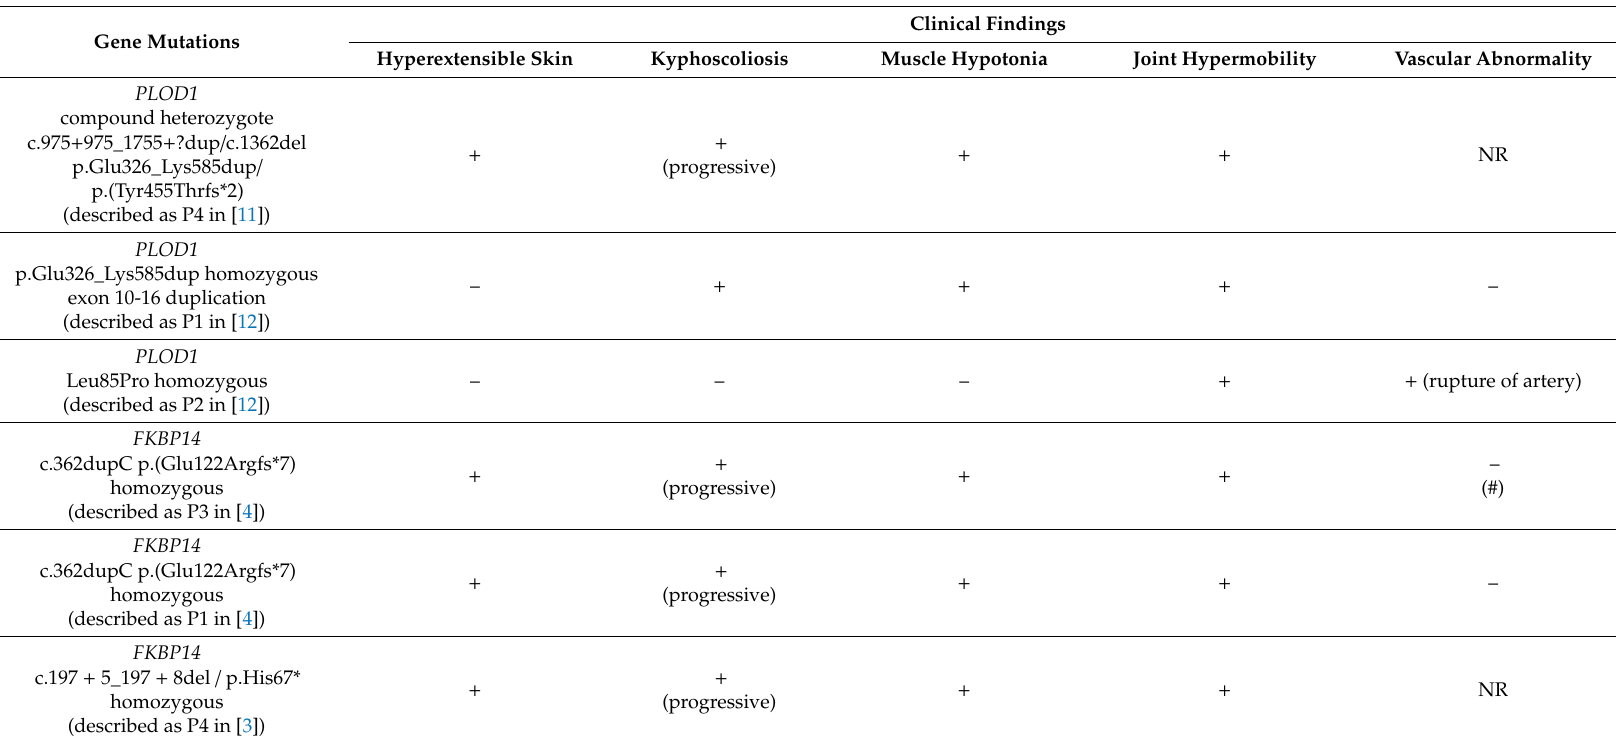
Table 1. Gene mutations and clinical presentations of FKBP14 -kEDS and PLOD1 -kEDS patients included in this